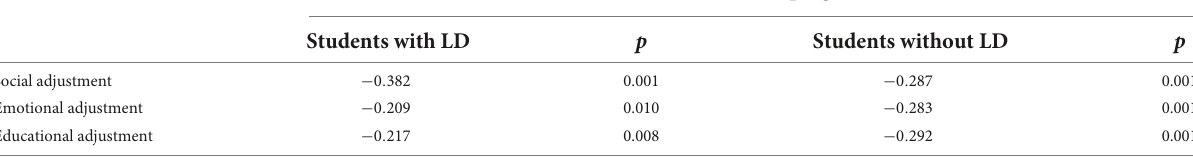
TABLE 1 Correlational analysis: Proactive coping and adjustment among students with and without learning disabilities.